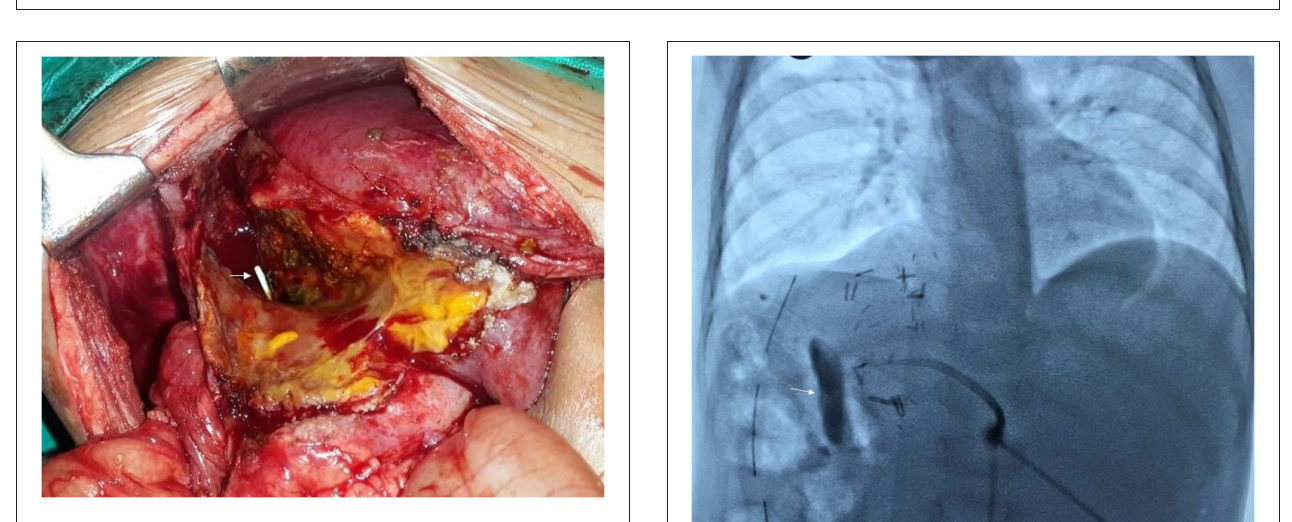
FIGURE 3 | Intraoperative photograph showing the stent protruding into the peritoneal cavity (arrow) from the hepatic duct confluence. conservative management for bile leak includes establishing